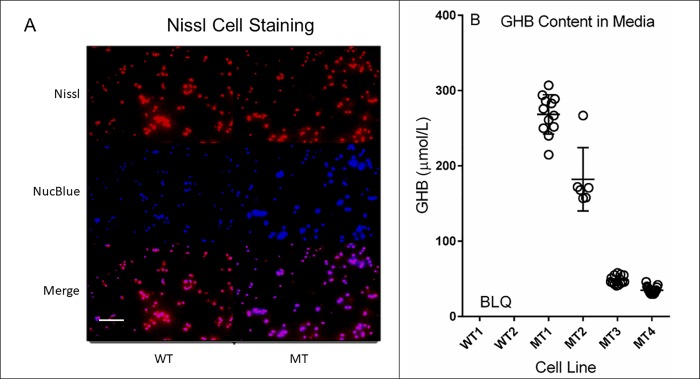
Nissl staining of neural stem cells (NSCs) and cell culture medium concentration of GHB as a function of cell line genotype.To confirm that NSCs retained features of neural cells, Nissl stain (red) was initially undertaken, and co-localization with a nuclear stain (blue) was performed to confirm that cells were of neuronal origin (A), although the Nissl stain does not differentiate mature neurons from progenitors. Scale bar = 50 μm (white bar). GHB concentration in cell culture medium is also displayed as a function of donor cell line (B). Media were collected for 24 h following addition of fresh medium and quantified for GHB content employing isotope-dilution gas chromatography-mass spectrometry [29]. GHB content was normalized to the recovery of 2H6-GHB, the latter added to each medium sample as internal standard stable isotope. The lower limit of quantification for this assay was 30 μM; all wild-type samples were below the limit of quantification (BLQ). Error bars display mean and SD. Abbreviations: WT, wild-type; MT, mutant. Statistical analysis employed one-way ANOVA (F (3, 42) = 378.9; p < 0.0001).